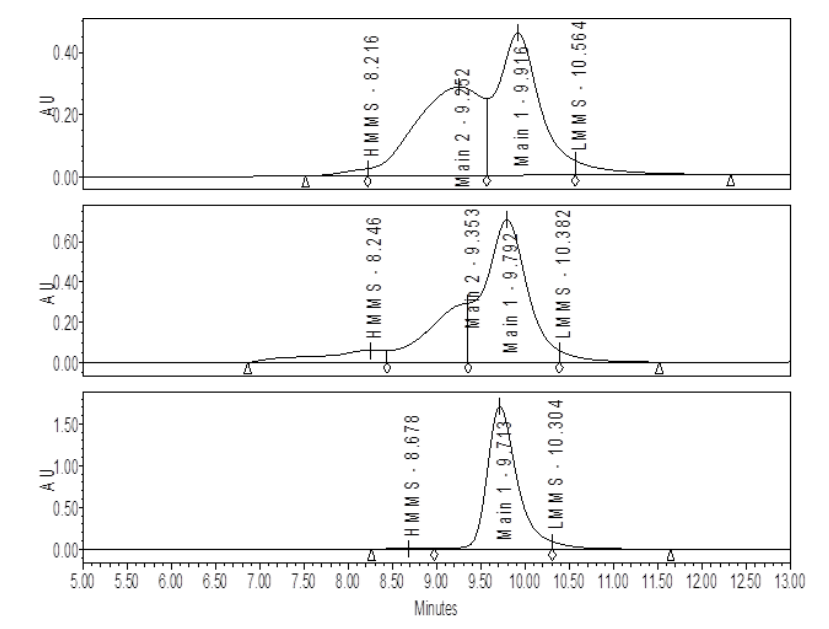
Figure 1. Size-exclusion chromatography (SE-HPLC) chromatograms for NIC7 conjugates made with high and low ratios of sulfo N -hydroxysuccinimide (sNHS) and 1-ethyl-3-(3-dimethylamino)propyl carbodiimide hydrochloride (EDC). The top panel shows the SE-HPLC profile for a conjugate produced with a sNHS/EDC ratio of 0.14. For this sample, the amount of Main 1 vs. Main 2 is almost 1:1. The middle panel shows the SE-HPLC profile for a conjugate produced with a sNHS/EDC ratio of 0.86 and Main 2 is present to a much lower extent. The bottom panel shows a control sample of unconjugated CRM 197 showing that Main 2 is not present.